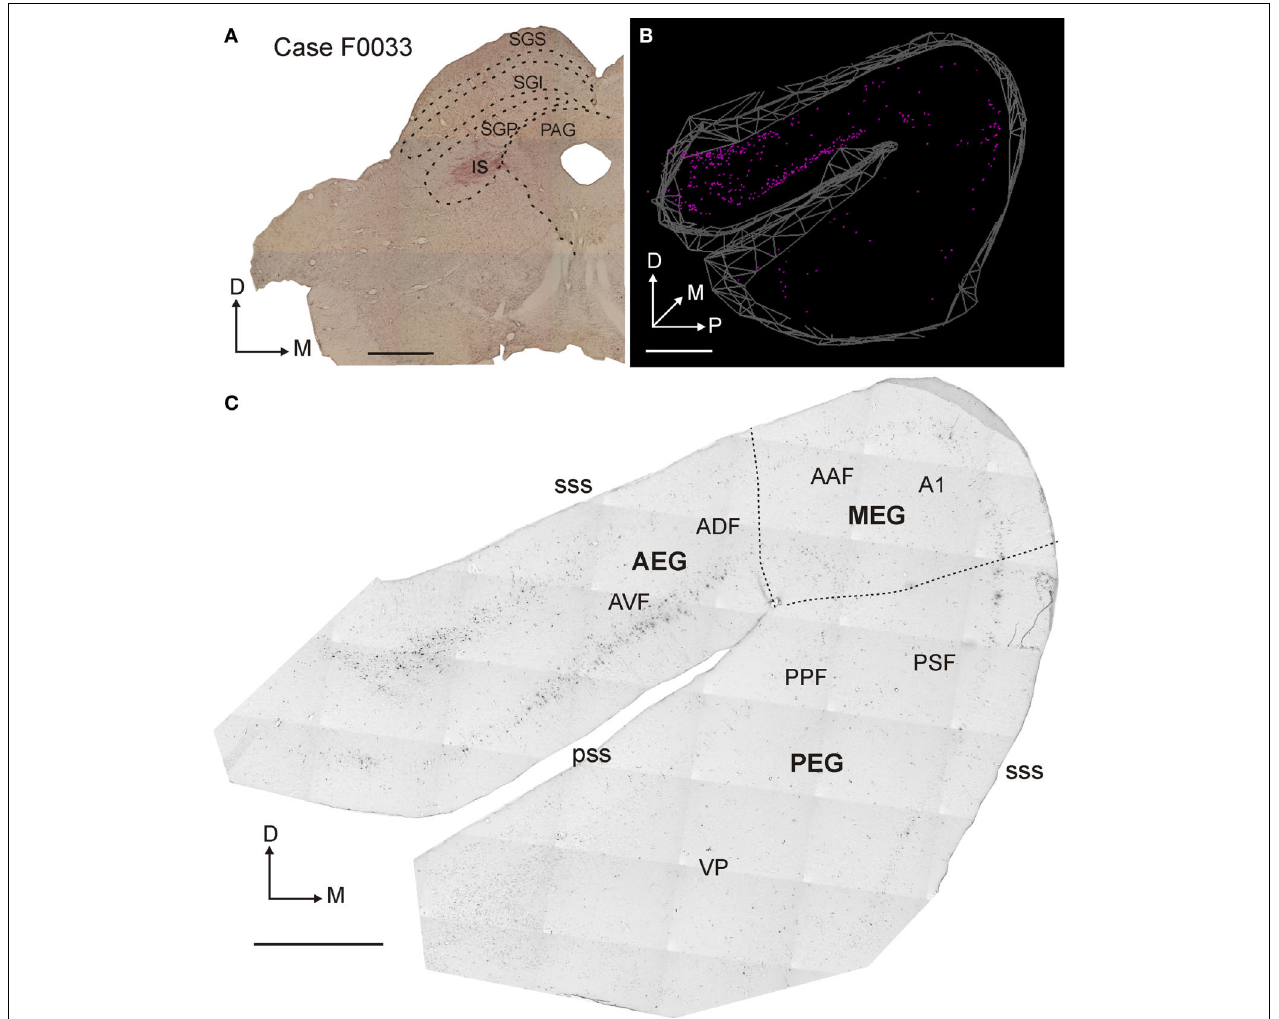
FIGURE 2 | Distribution of retrogradely labeled cells in the auditory cortex after rhodamine (FR) injection in the superior colliculus. (A) Coronal section at the level of the left SC showing the injection site in the deep SC (SGP). (B) 3D reconstruction of auditory cortex showing the location of retrogradely labeled